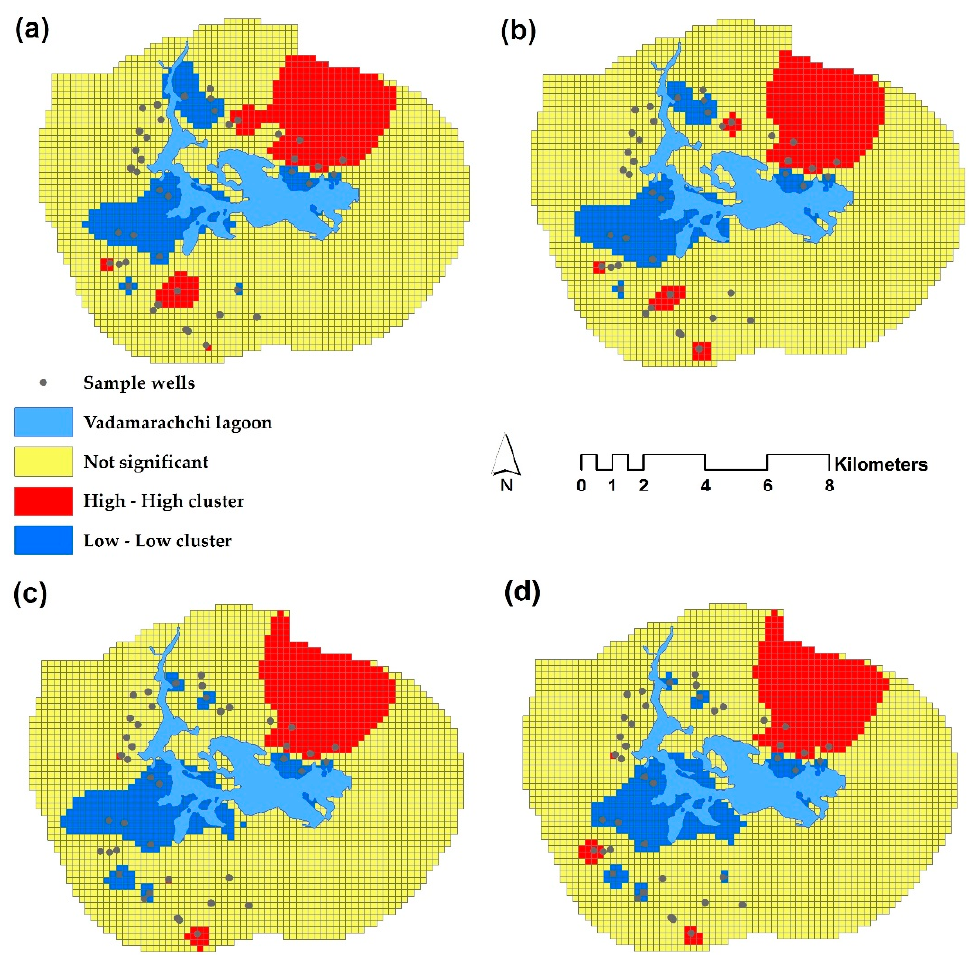
Figure 9. The spatial pattern of local indicators of spatial autocorrelations clusters of depth to water during the dry season: ( a ) March, ( b ) April, ( c ) May, and ( d ) June.